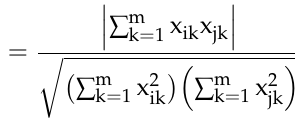
predicted PPVs by the ANN, EF-1, EF-2, EF-3, ISEE model, USBM model, MLRA, and MnLRA, respectively.